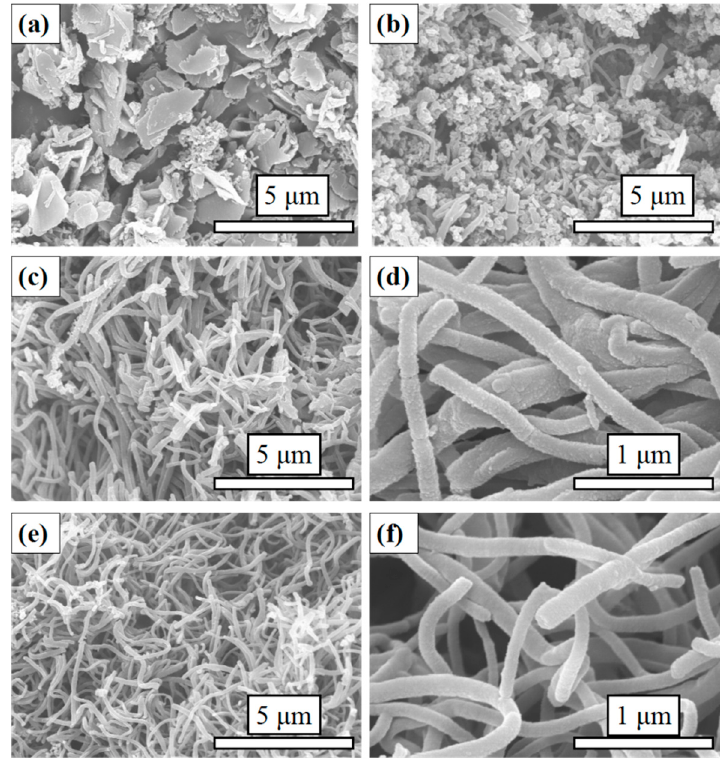
Figure 2. SEM images of ( a ) DW, ( b ) SC, ( c ) and ( d ) PANI, ( e ) and ( f ) NCFs. Appl. Sci. 2018 , 8 , x FOR PEER REVIEW